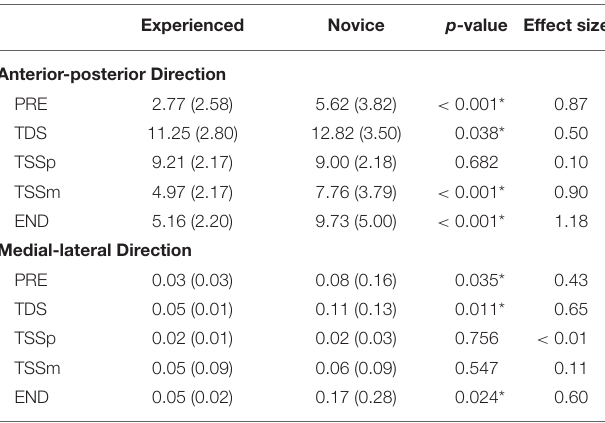
TABLE 2 | Range (SD) of COM-COP (PRE, TDS) and COM-ankle (TSSp, TSSm) inclination angles (degrees).